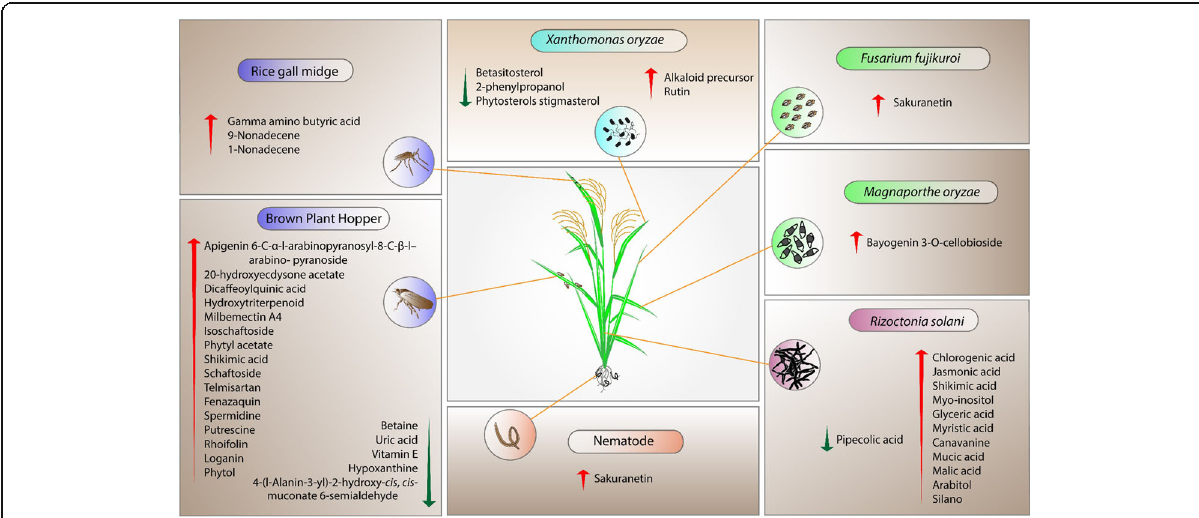
Fig. 1 Potent metabolites linked to stress resistance in rice. Those metabolites were specifically increased (red arrow) or decreased (green arrow) in resistant plants as compared to susceptible plants in indicated studies (Table 2, marked by a ). SA: salicylic acid, JA: jasmonic